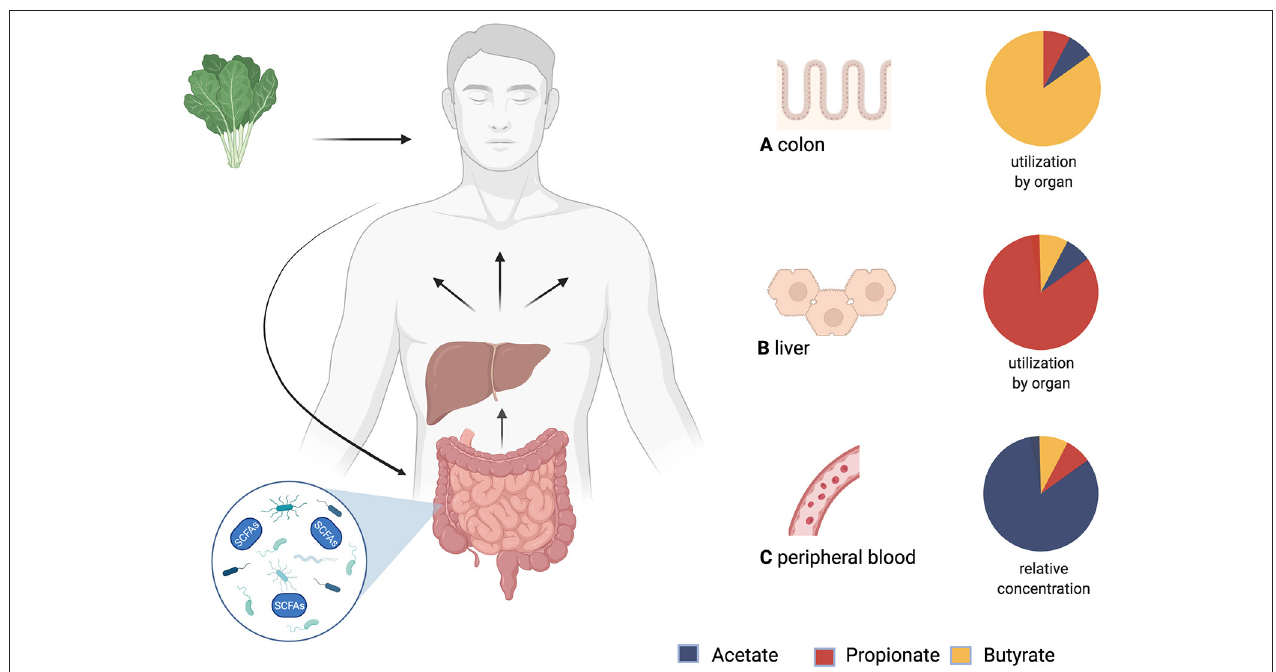
FIGURE 1 | Production, distribution and yield of short-chain fatty acids (SCFAs) in different tissues. After consumption, undigested fiber reaches the colon and is fermented by microbiota. The product of this process are SCFAs. Via the portal vein SCFAs are transported to the liver and then systemically distributed. (A) Utilization of SCFAs in the colon: Butyrate is an important energy source for colonocytes. (B) Utilization of SCFAs in the liver: Propionate is mostly metabolized in the liver. (C) Relative concentrations of SCFAs in peripheral blood: Acetate has the highest peripheral concentrations. This is followed by propionate, while butyrate shows the lowest peripheral concentrations ( 43). Created with